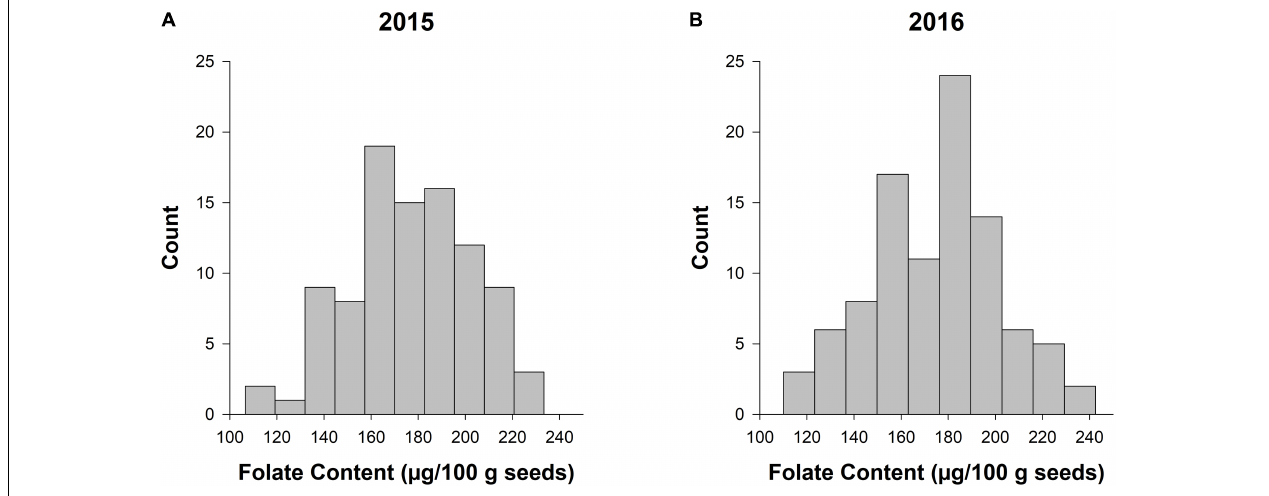
FIGURE 1 | Frequency histograms of total seed folate content in the diversity panel evaluated in 2015 and 2016. The counts for total seed folate are based on the least squared means from the separate ANOVAs for the experiments conducted in 2015 (A) and 2016 (B) .